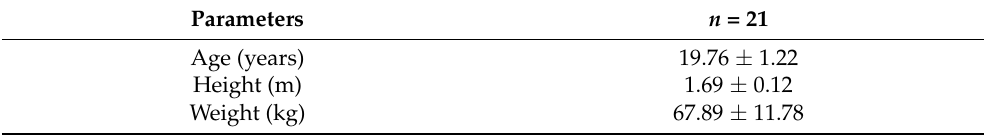
Table 1. Characteristics of the